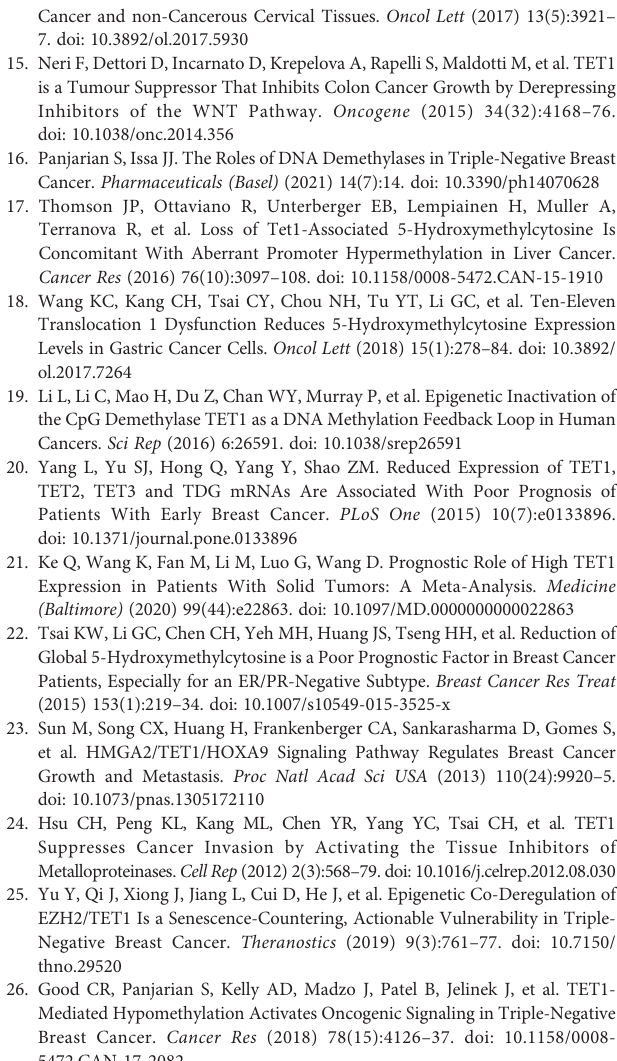
Supplementary Figure 1 | Validation of TET1 clones. (A, B) qRT-PCR on mRNA extracted from either MDA MB231 infected with TET1 (TET1) or MDA MB231 infected with empty vector (EV) using either TET1 speci fi c primers (A) or primer pair where the forward primer targets HA-tag while the reverse primer targets TET1 (B) . Results are shown after normalization to the level of the housekeeping gene hUBC and relative to mRNA levels in MDA MB231 control cells infected with empty vector. Bars represent SEM. * indicates that p-value is